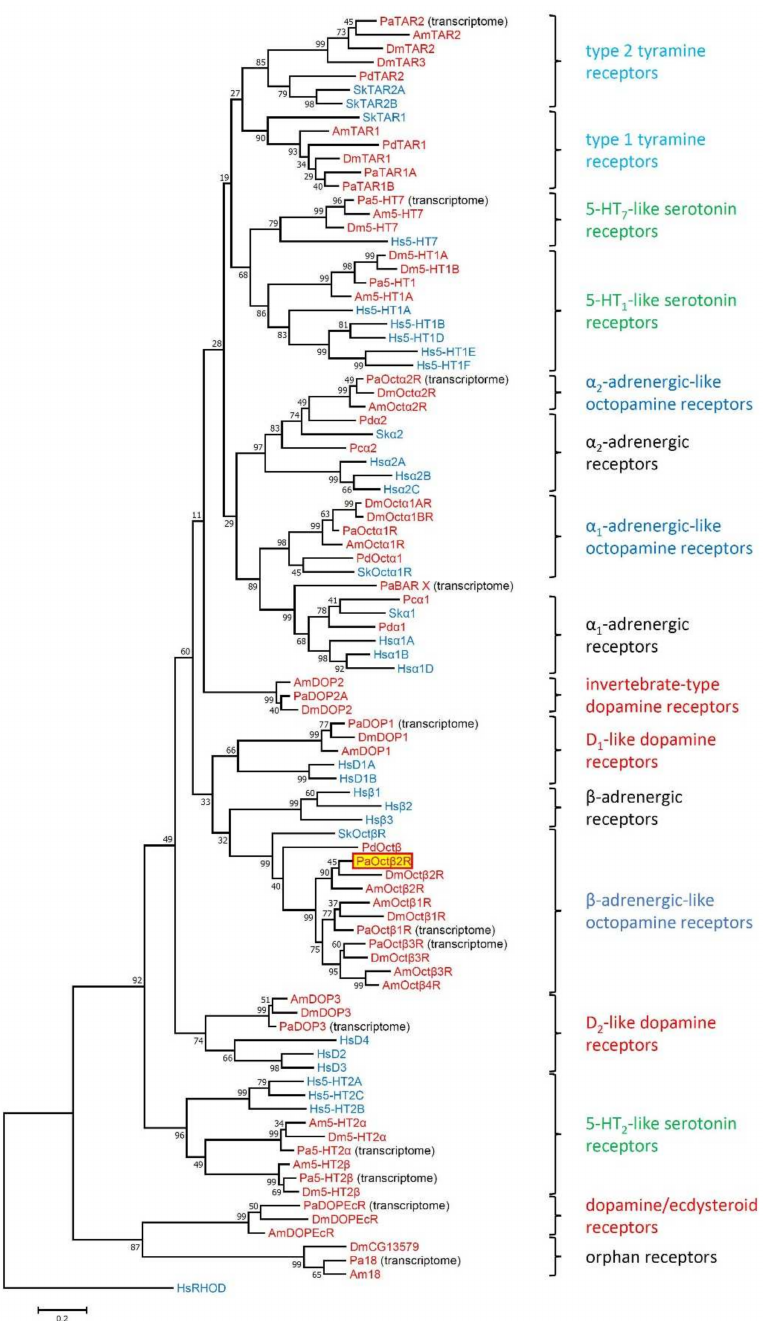
Figure 2. Phylogenetic relationships of monoaminergic receptors. Alignments were performed with BioEdit [40] by using the core amino-acid sequences of TM 1-4, TM 5, TM 6, and TM 7. The evolutionary history was inferred by using the Maximum Likelihood method based on the Poisson correction model. The tree with the highest log likelihood ( − 28600.17) is shown. The percentage of trees in which the associated taxa clustered together is shown next to the branches. The tree is drawn to scale, with branch lengths measured in the number of substitutions per site. The analysis